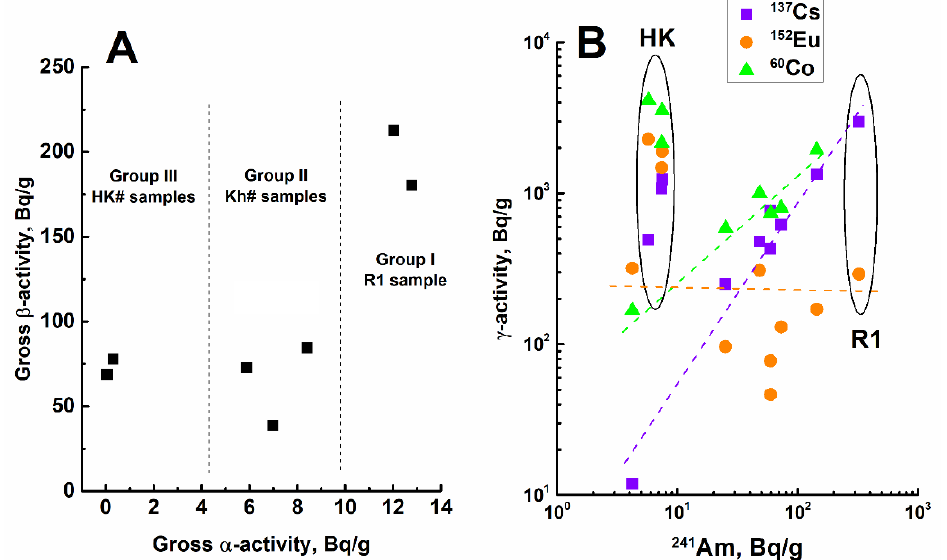
Figure 2. Radioactivity of the particles. ( A ) Gross α - and β - activity; vertical dashed lines separate different groups of the samples (see text); ( B ) γ -spectroscopy data of three groups of particles: the circle marked as “R1” shows Group I; the circle HK is related to Group III; all other points belong to Group II (“Khariton” particles). The lines are just to guide the eye.